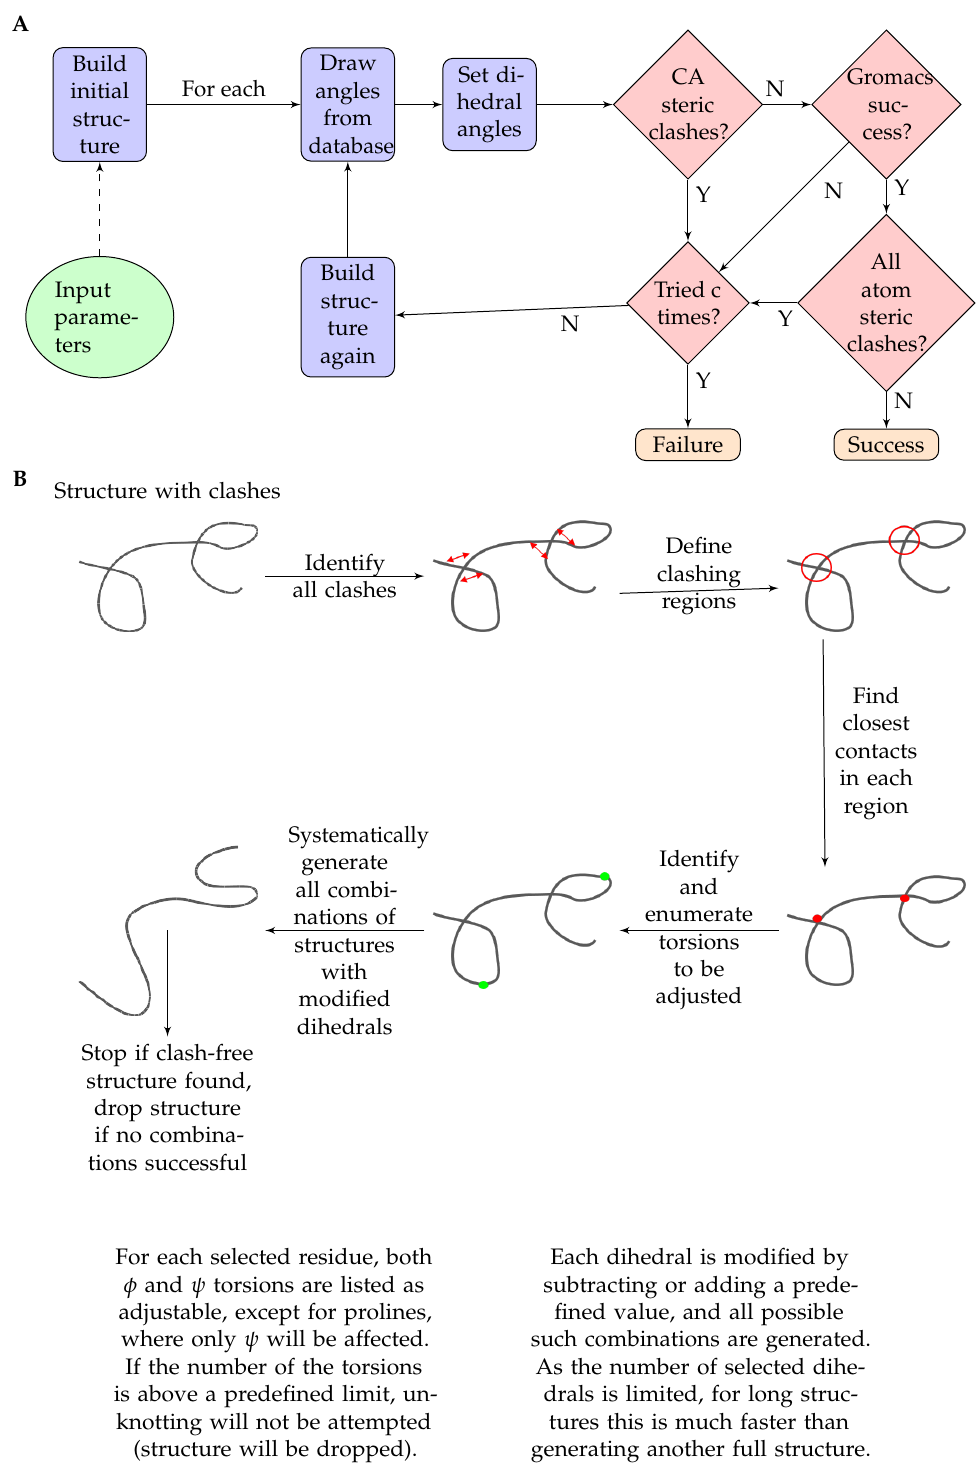
Figure 1. ( A ) Flowchart of the steps of the pipeline DIPEND (DIsordered Protein Ensembles from Neighbor-dependent Distributions). ( B ) Flowchart of the unknotting part of the DIPEND